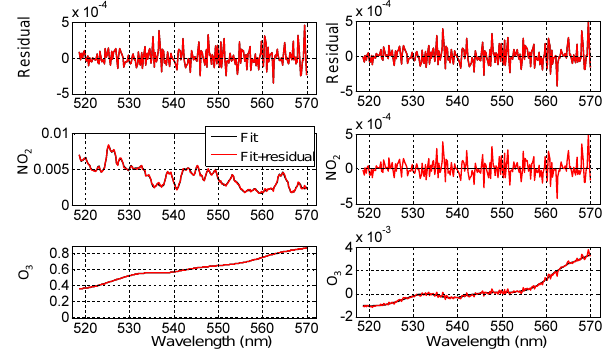
Figure 12. Same as Fig. 11 but for the visible fit